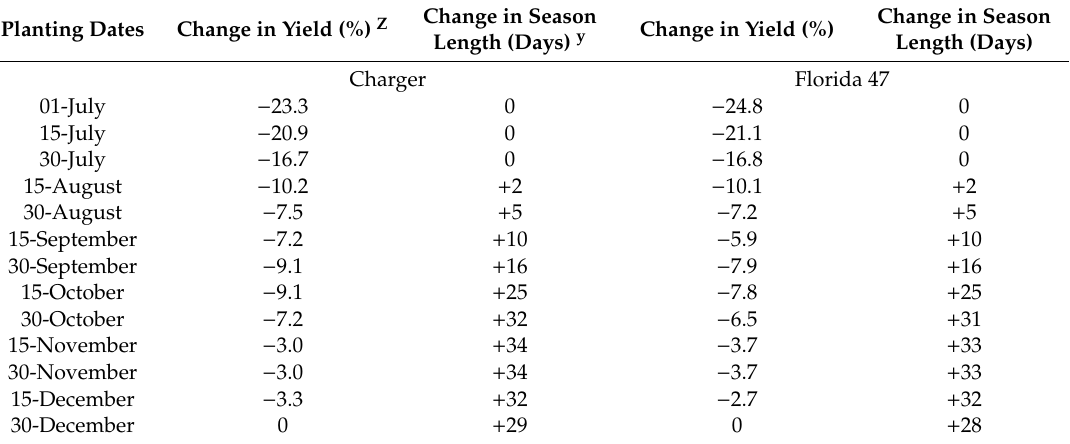
Table 5. E ff ects of planting dates on changes in yield and length of growing season of two commercial tomato varieties in Immokalee